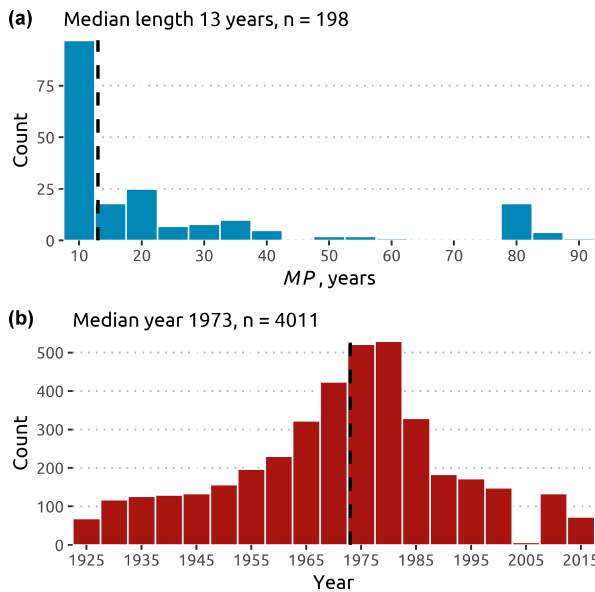
Figure 1. Temporal coverage of the Caucasus SSY database. A: dis- tribution of the measuring periods for which gauging station SSY observations are available. B: amount of catchment-year SSY data available per 5-year